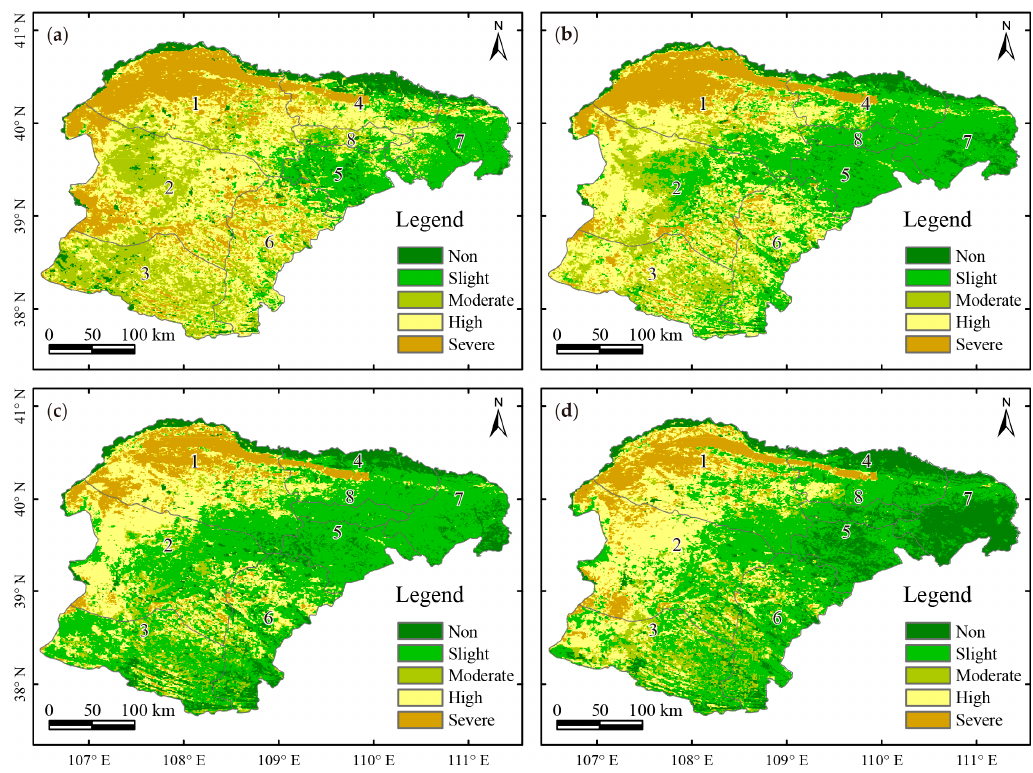
Figure 4. Desertification assessment results of four periods: ( a ) 2000; ( b ) 2006; ( c ) 2010 and ( d ) 2015.